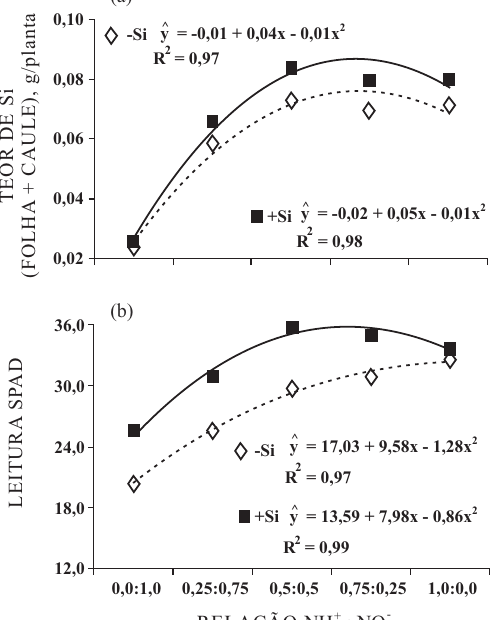
Figura 4. Teor de silício disponível no solo, extraído em CaCl , em função do pH do solo. (a) solo não- 2 rizosférico; e (b) solo